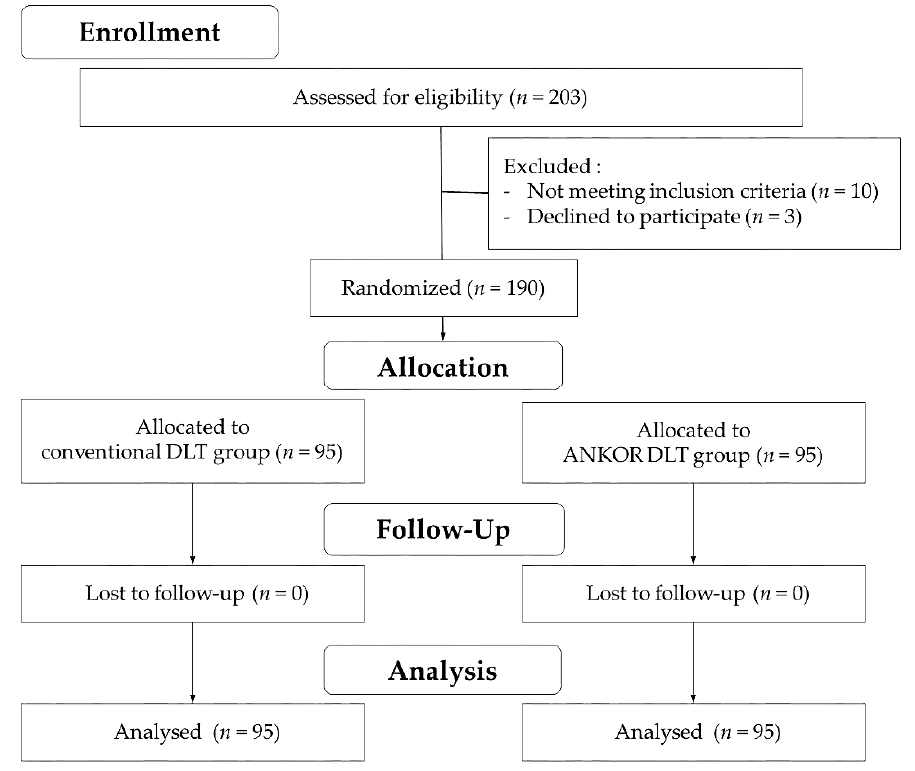
Figure 1. CONSORTflowdiagram. DLT,double-lumenendobronchialtube; Figure 1. CONSORT flow diagram. DLT, double-lumen endobronchial tube; FOB, fiberoptic bronchoscopy.